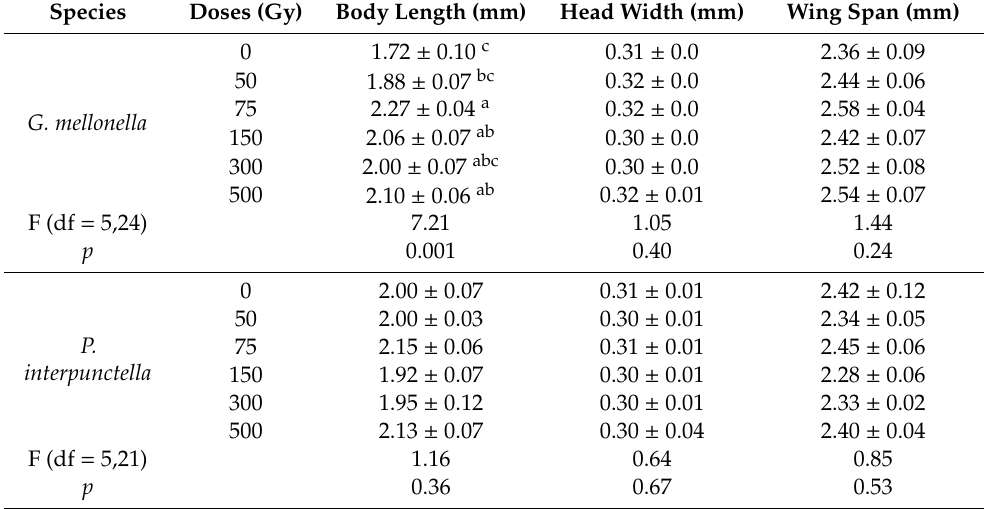
Table 1. Mean ( ± SE) size of male adult parasitoid H. hebetor developing from the irradiated larvae of G. mellonella and P. interpunctella.